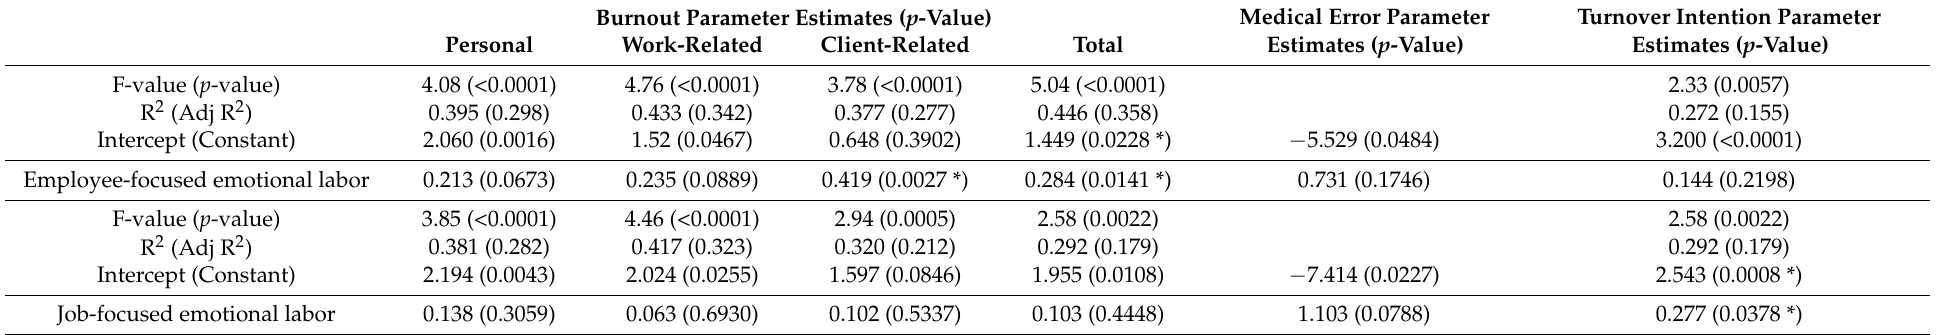
Table 3. Influence of emotional labor on burnout, medical error, and turnover intention (N = 117).